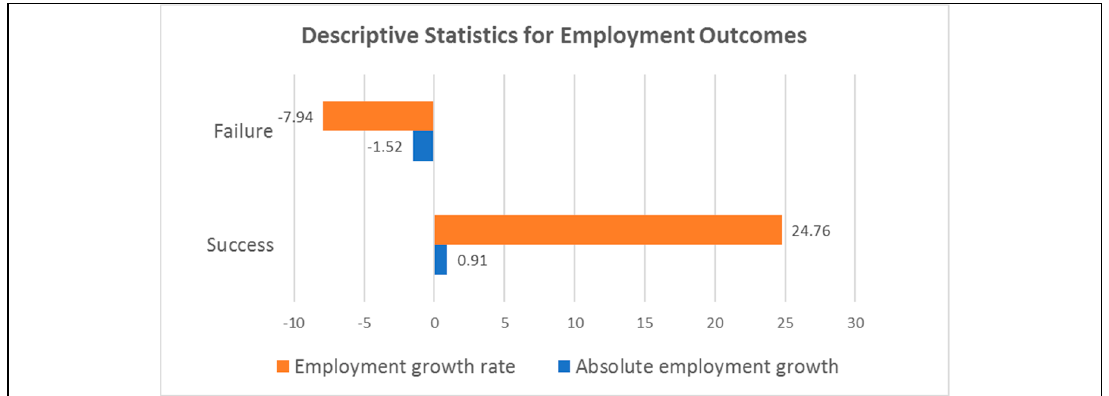
Figure 2. Bar chart of descriptive statistics for employment outcomes.